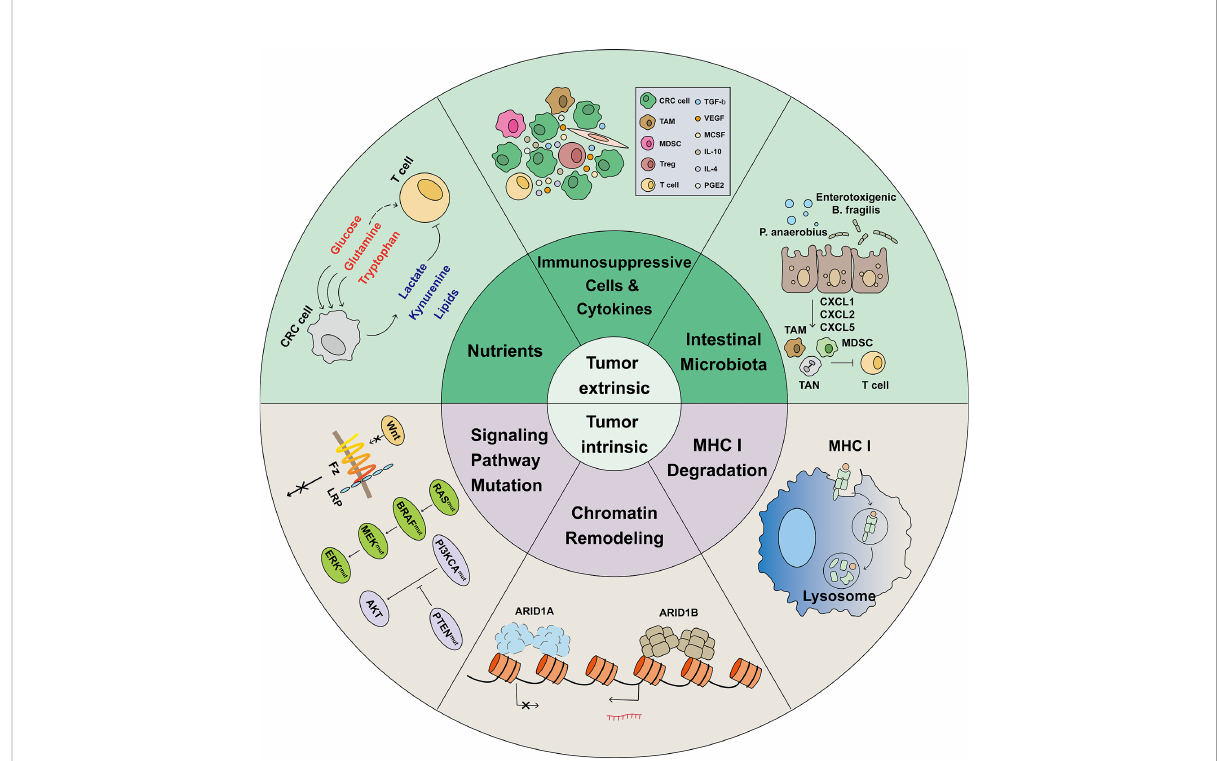
FIGURE 2 Mechanisms associated with immunotherapy resistance. The limited effectiveness of immunotherapy is primarily due to various mechanisms of immunotherapy resistance. In the heterogeneous tumor microenvironment, cells such as Tregs, MDSCs, and TAMs, combined with tumor- released immunosuppressive cytokines, induce tumor in fi ltrating lymphocytes (TILs) exhaustion. In the TME, tumor cells have a greater ability to compete for nutrients, such as glucose, glutamine, and tryptophan, which are necessary for proper cellular function. Meanwhile, tumor cells release lactate, kynurenine, and Oxidized low density lipoprotein (oxLDLs), which are harmful to TILs. In CRC, intestinal microbiota such as P. anaerobius and enterotoxigenic B fragilis induce tumor cells to release CXCL1, CXCL2, and CXCL5 and recruit immunosuppressive cells. Before identifying and killing TILs, tumor cells activate the lysosomal degradation pathway of MHC class 1 to escape T cell killing. The switching/ sucrose non-fermentable (SWI/SNF) complex has been identi fi ed as a tumor suppressor gene in CRC; AT-Rich Interactive Domain-containing protein 1A (ARID1A) is the most frequent target of SWI/SNF mutations. However, ARID1A mutations was found correlated with markedly higher level of immune in fi ltrates in colon cancer. Gene and signal pathway mutations, such as those in WNT, RAS, BRAF, MEK, ERK, PI3KCA, and PTEN, were reported to be associated with immunotherapy